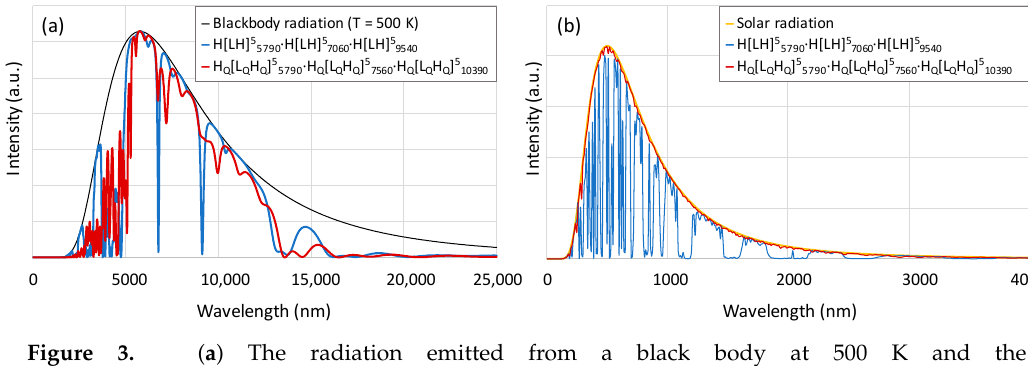
Figure 3. ( a ) The radiation emitted from a black body at 500 K and the amount of this radiation that is reflected by H[LH] 55790 ·H[LH] 57060 ·H[LH] 59540 , and H Q [L Q H Q ] 55790 ·H Q [L Q H Q ] 57560 ·H Q [L Q H Q ] 510390 . ( b ) The solar transmitted